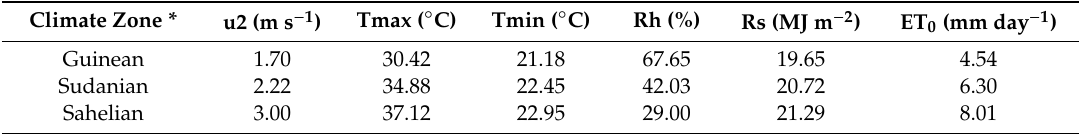
Table 1. Average values of climatic